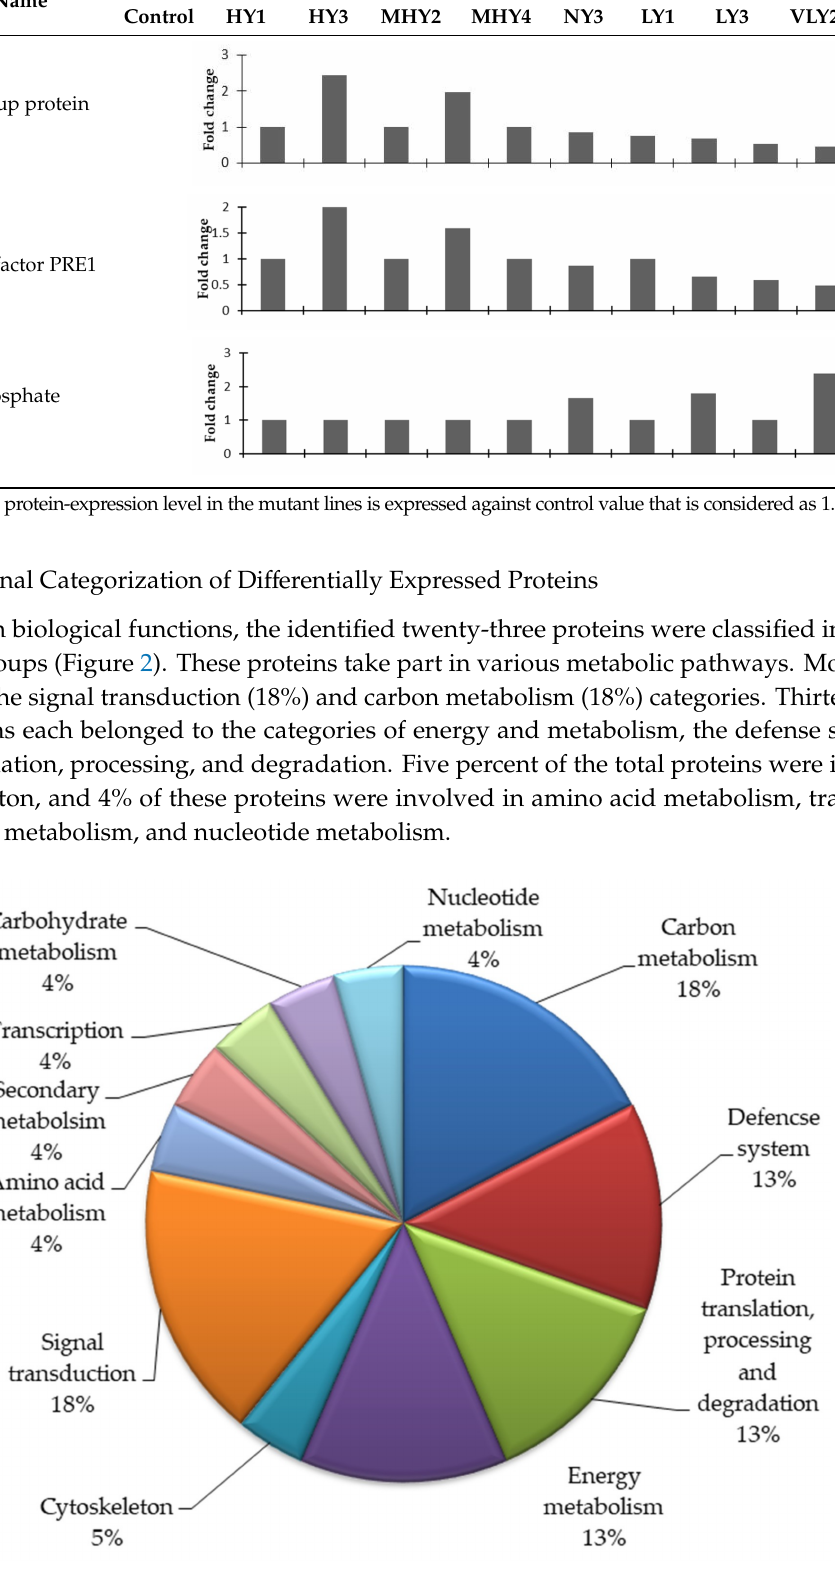
Figure 2. Functional categorization of the identified proteins in the mutant lines of Nigella sativa